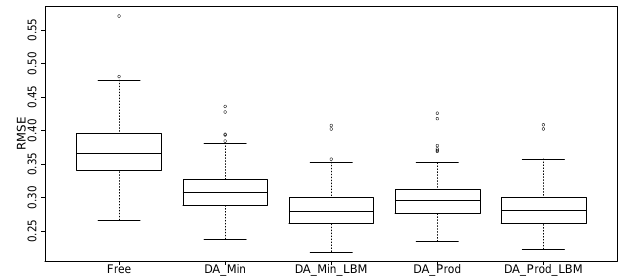
Figure 8. Global yearly near-surface temperature RMSE box plots for the free ensemble run forecast ( free ) and the analysis of the off- line DA runs using VSL-Min observation operator and climatolog- ical soil moisture (DA_M IN ), VSL-Min observation operator and leaky bucket model (DA_M IN _LBM), VSL-Prod observation op- erator and climatological soil moisture (DA_P ROD ), and VSL-Prod observation operator and leaky bucket model (DA_P ROD _LBM).